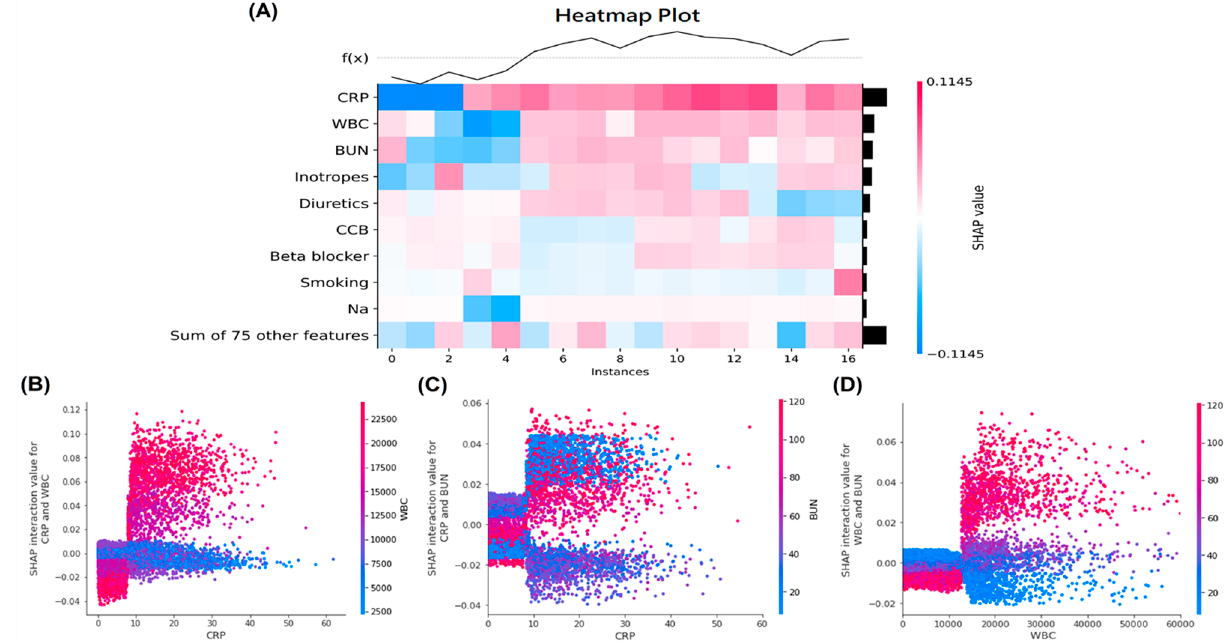
Figure 3. ( A ) The SHAP heatmap plot with the model’s predictions for important features. The heatmap plot function creates a plot with the features on the y-axis, the model inputs on the x-axis, and the SHAP values encoded on a color scale with a higher value being redder, and a lower value being bluer. The SHAP dependence plots showed the interaction effects between ( B ) CRP and WBC, ( C ) CRP and BUN and ( D ) WBC and BUN in the LGBM model. Abbreviations: SHAP, SHapley Additive exPlanation; CRP, C-reactive protein; WBC, white blood cell counts; BUN, blood urea nitrogen; LGBM, light gradient boosting